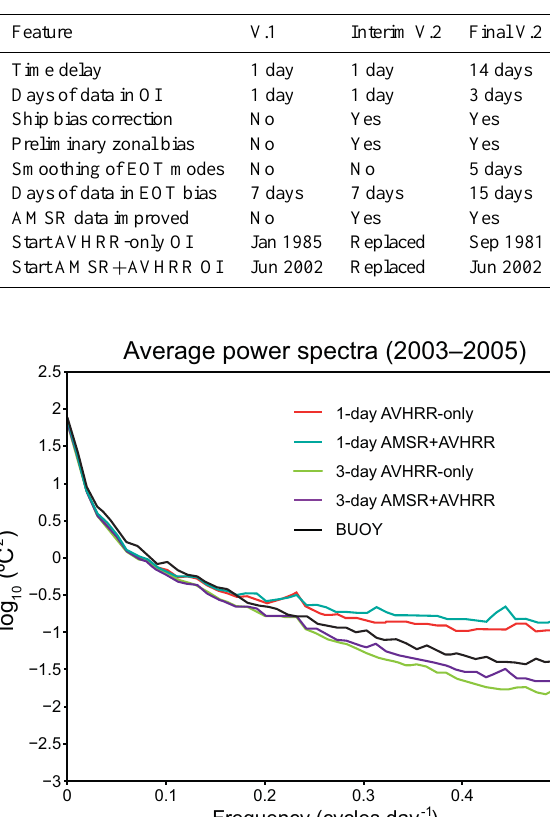
Table A2. Comparison of different versions.